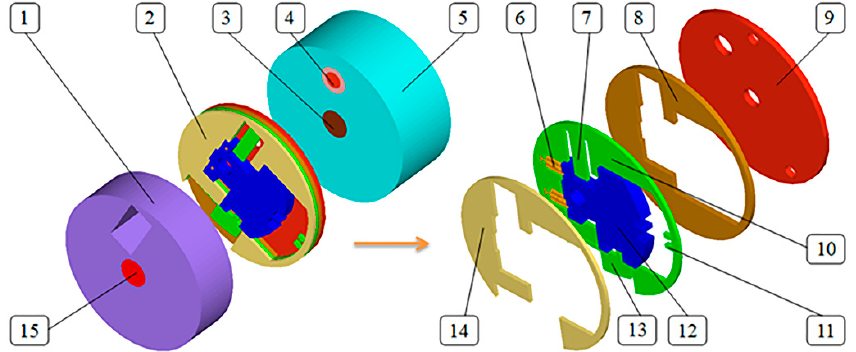
Figure 1. Designed Micro S & A device. 1 — Detonating tube base; 2 — Micro S & A module; 3 — Electric